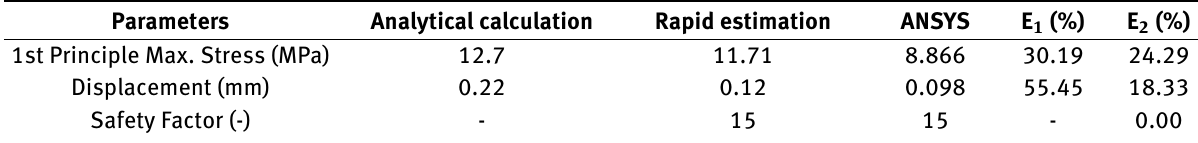
Table 2: Error comparison of the analytical calculations, rapid estimation (Autodesk Inventor) and ANSYS: body part of the driver